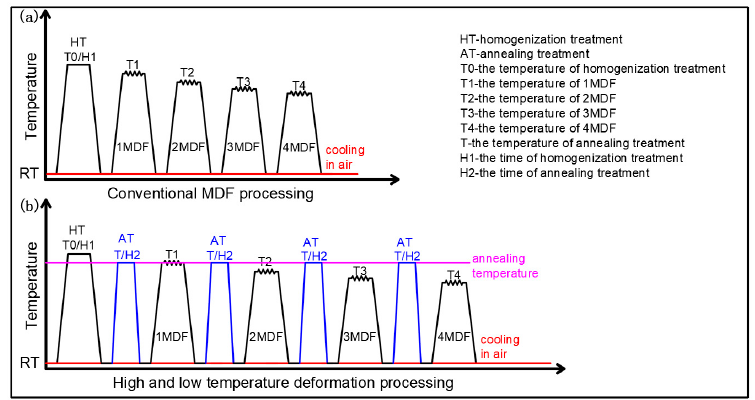
Figure 1. The chart of MDF process: ( a ) Conventional method, ( b ) high and low temperature cycle deformation